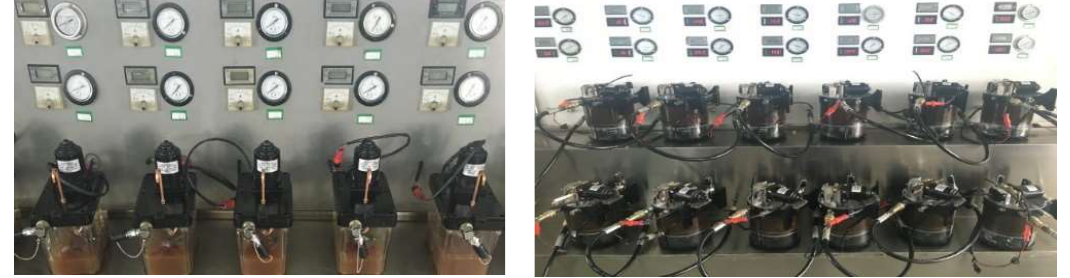
Figure 6. Physical map of test equipment.